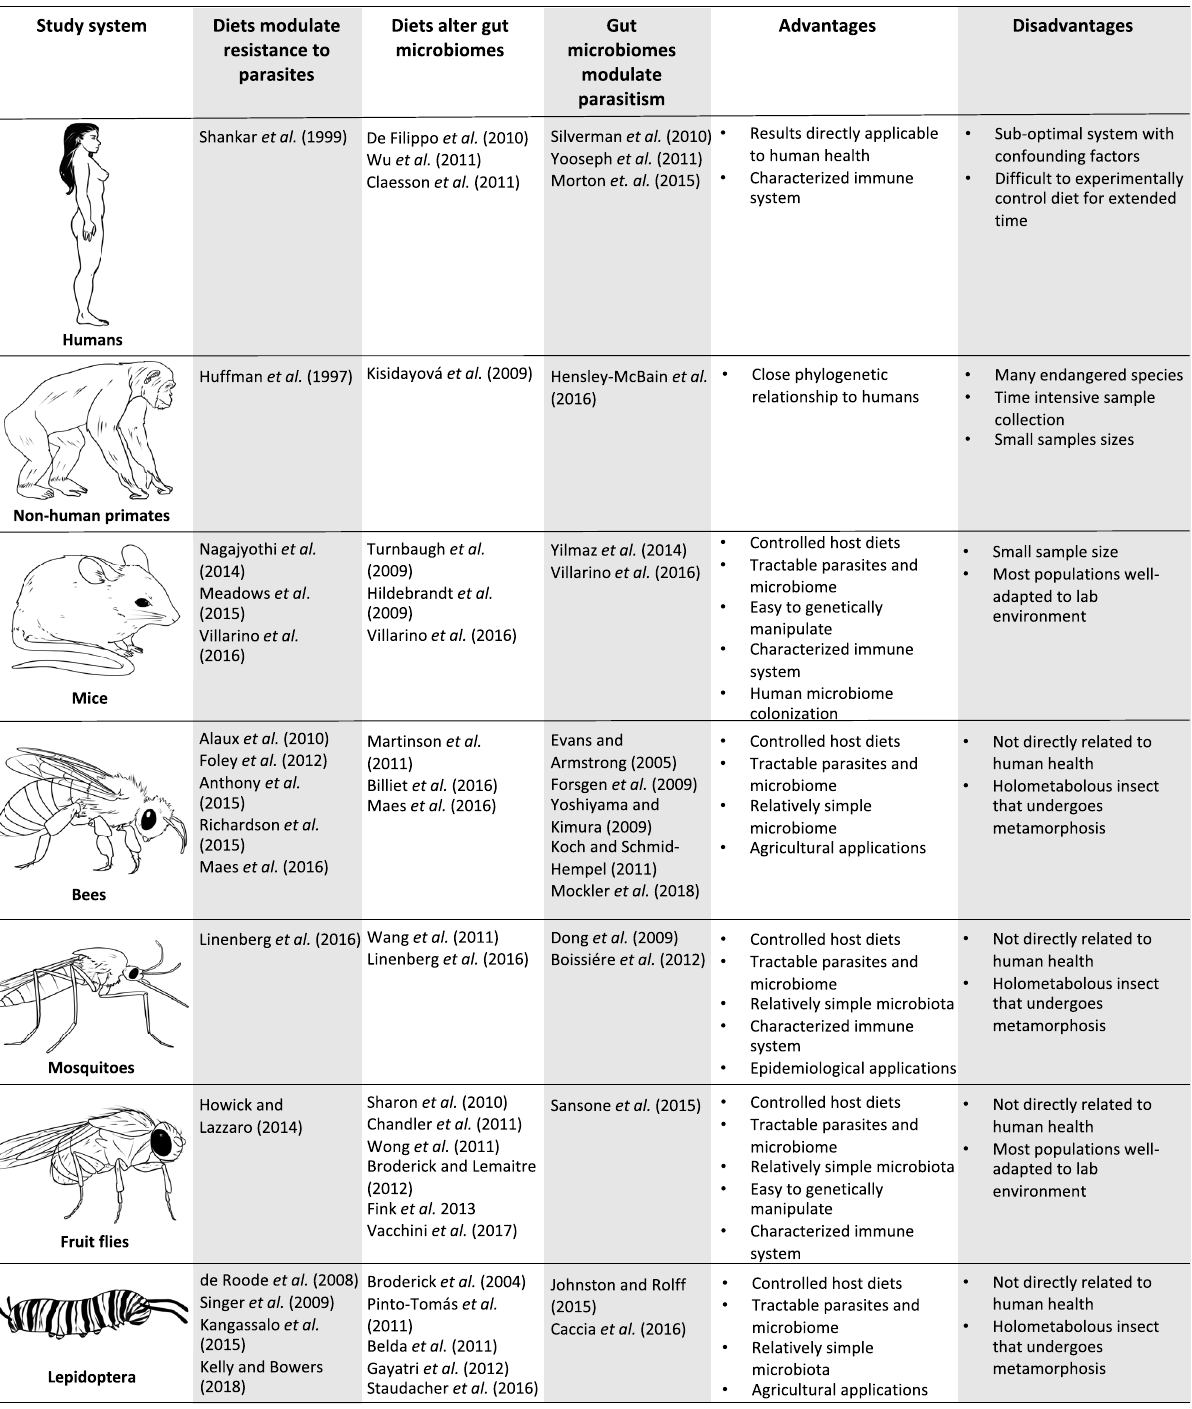
Fig 2. Animal systems showing three separate, direct relationships between diet, parasites, and the gut microbiome. Mice and insects are ideal systems to study the potential indirect, three-way link due to the systems’ controlled host diets, tractable and relatively simple microbiota, and tractability of